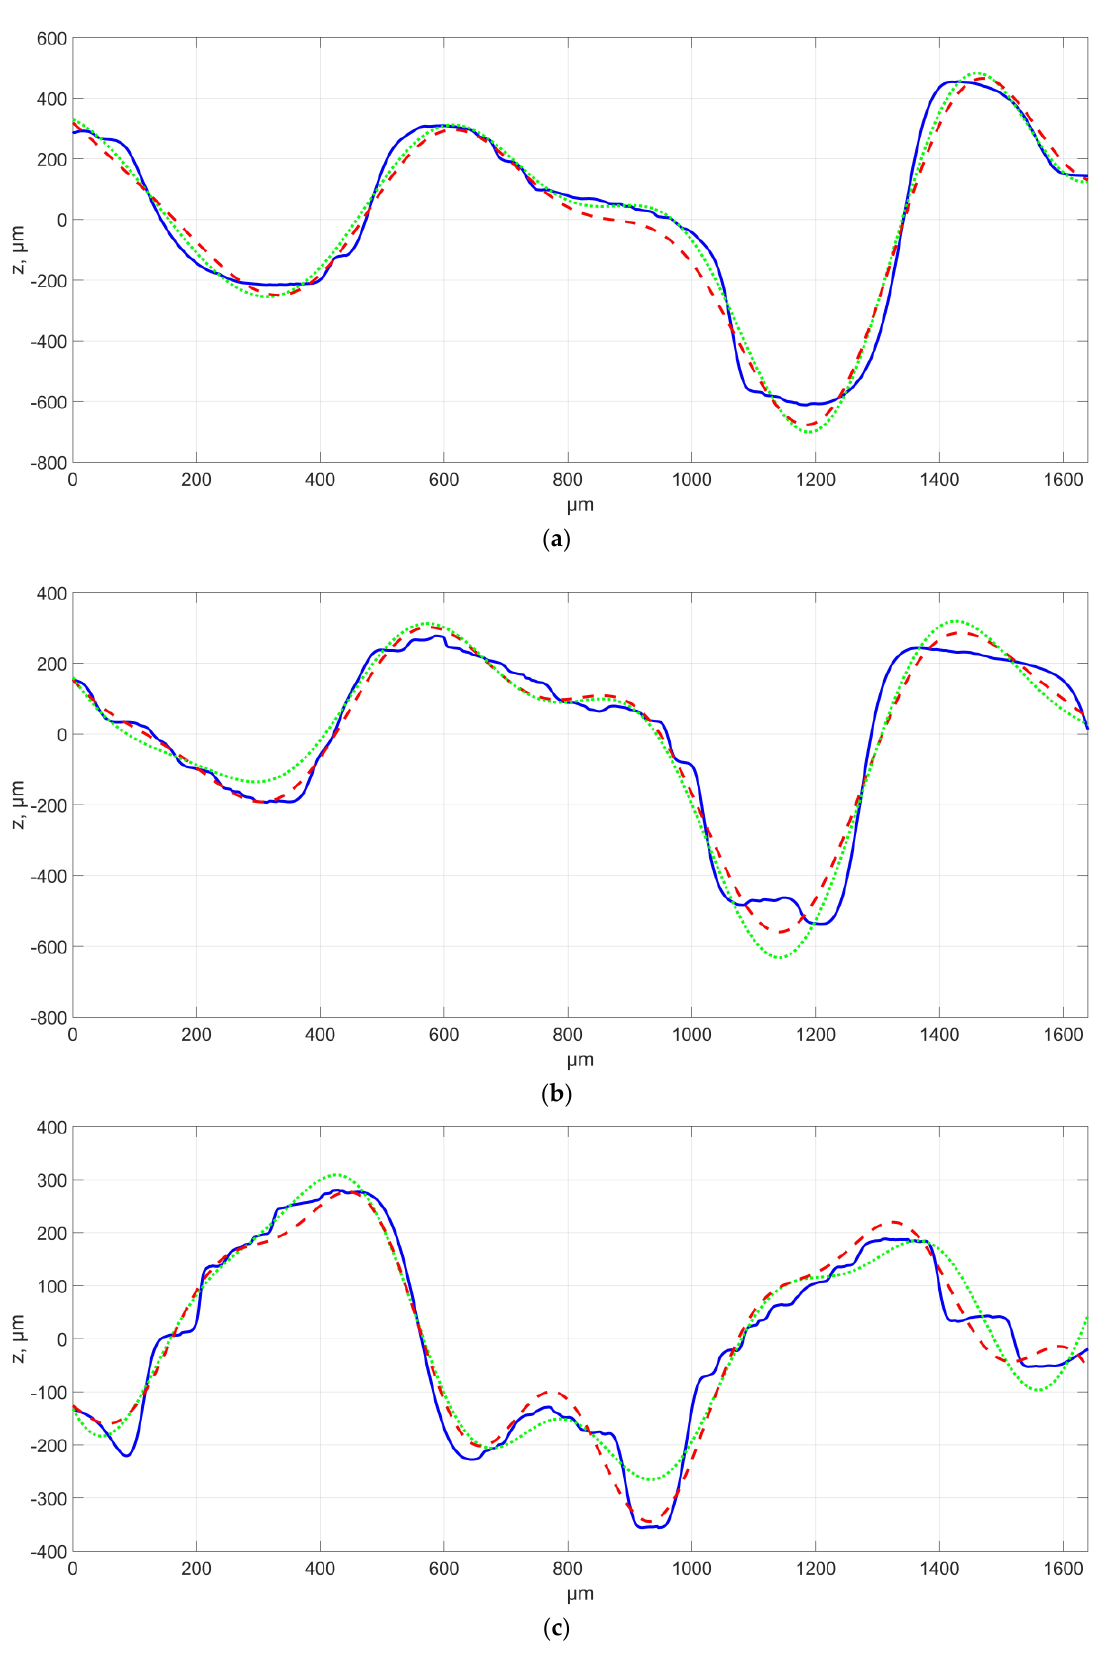
Figure 4. Example of a surface profile for samples No. 4–6 with an approximating function, respectively, as a function of construction angle, ( a ) 20°, ( b ) 45°, ( c ) 70°. The blue color indicates the measured profile, the red color indicates approximation, and the green color indicates CAD model.